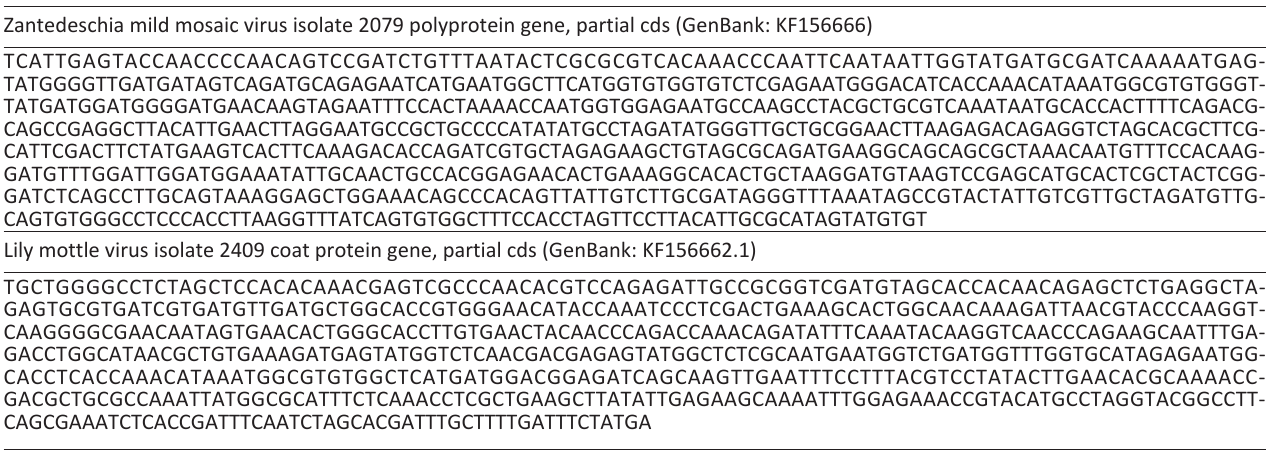
Table 3 - Sequence of isolates of Zantedeschia mild mosaic virus and Lily mottle virus isolate detected in Italy Zantedeschia mild mosaic virus isolate 2079 polyprotein gene, partial cds (GenBank: